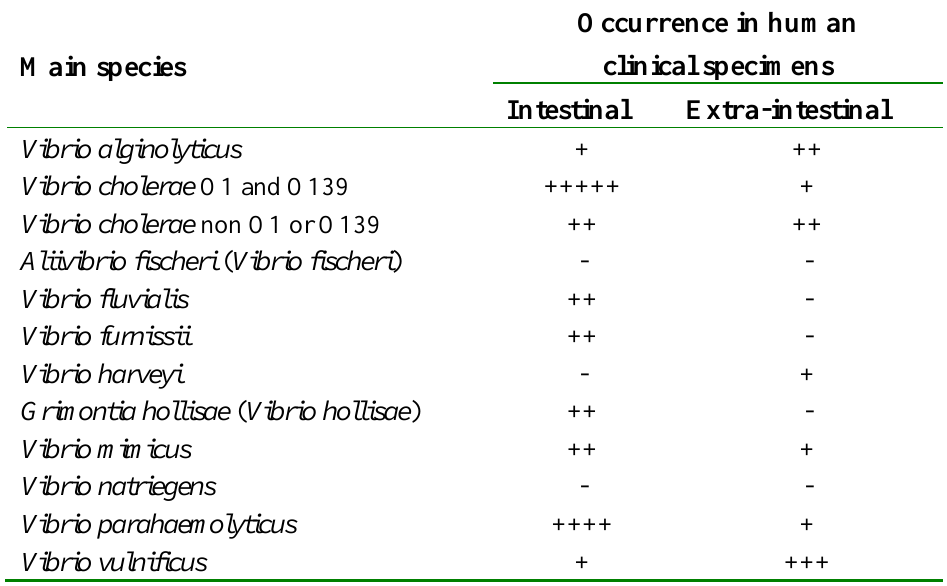
Table 2 . Main species of Vibrio and their occurrence in human clinical specimens a . Main species